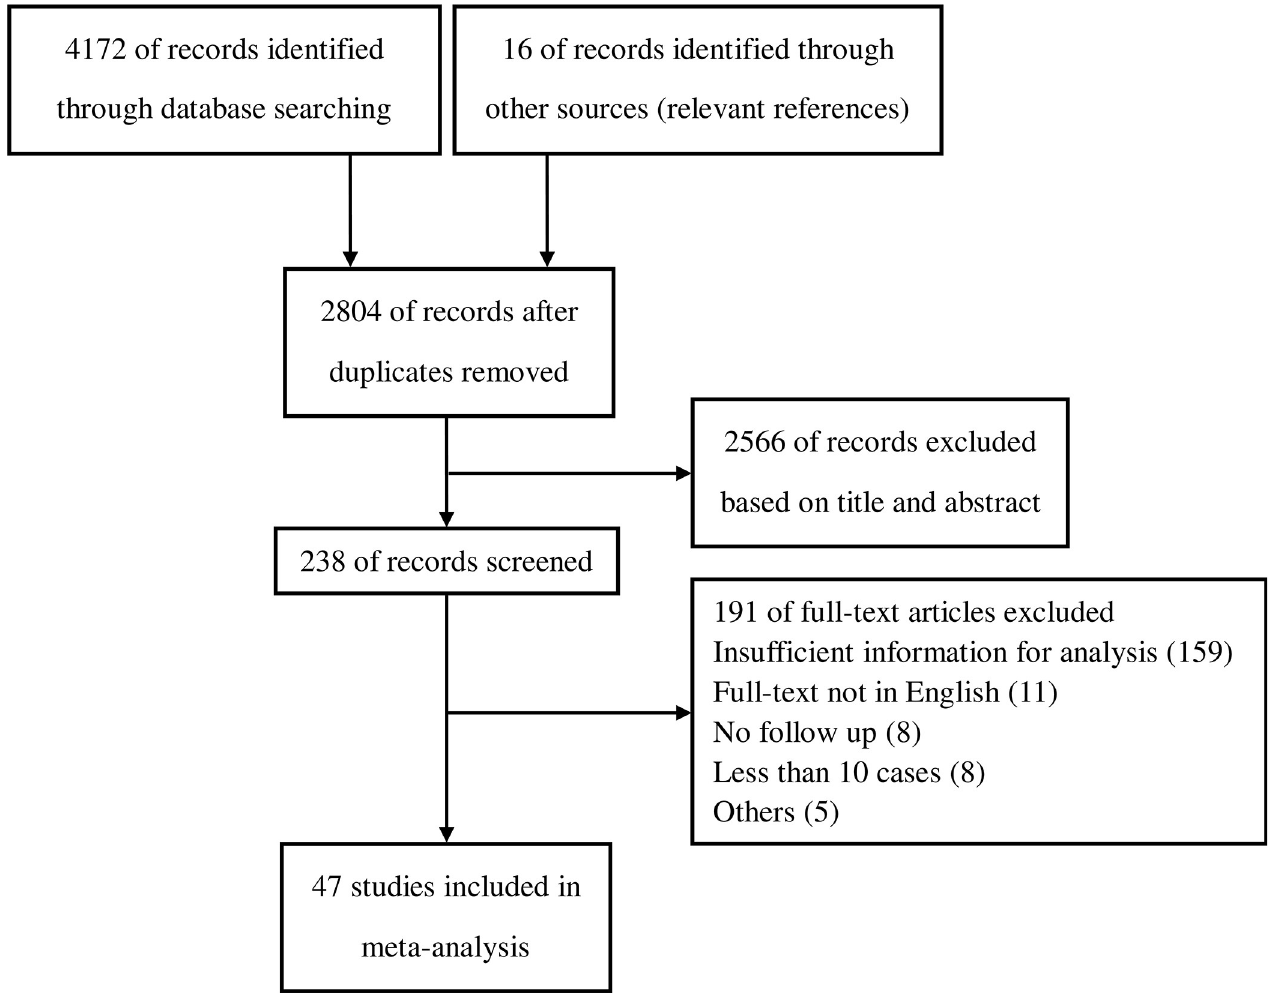
Fig 1. PRISMA flow